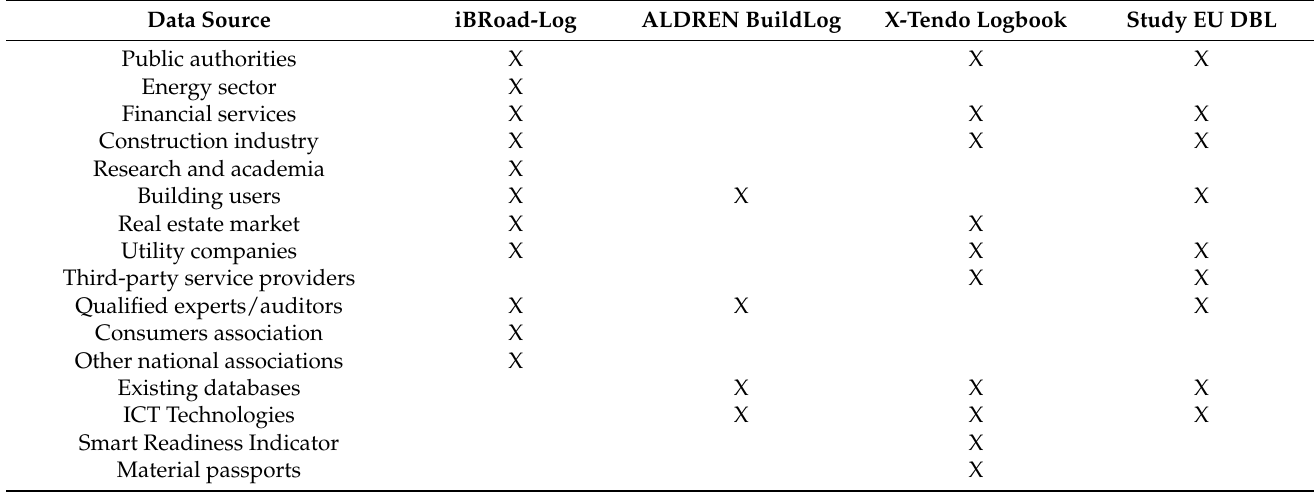
Table 7. Data sources for the DBL.